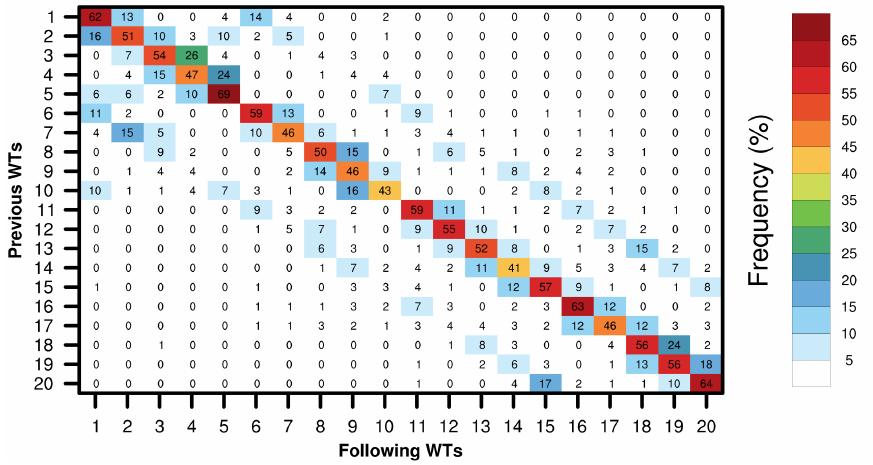
Figure 4. Frequency of transitions between weather types calculated as a percentage of the sum of all cases for each pattern.